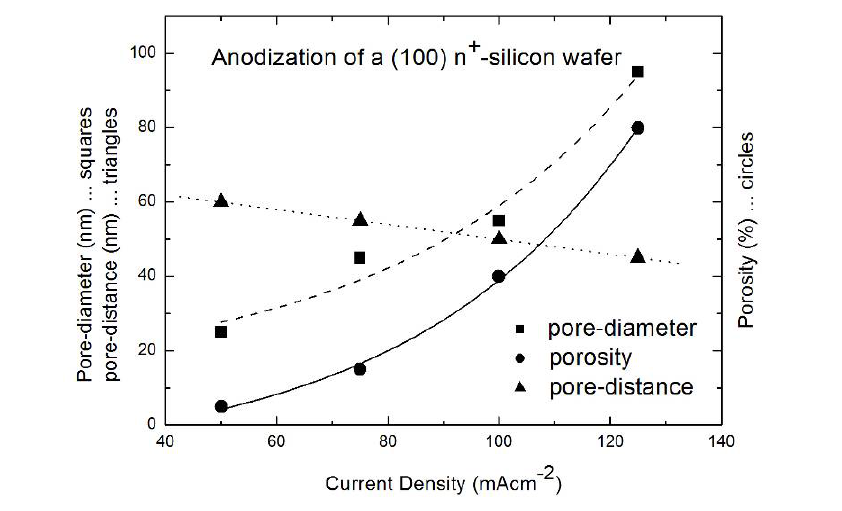
Figure 9. Decreasing pore-diameter and porosity with decreasing current density. The pore-distance is enhanced with decreasing current density (data from